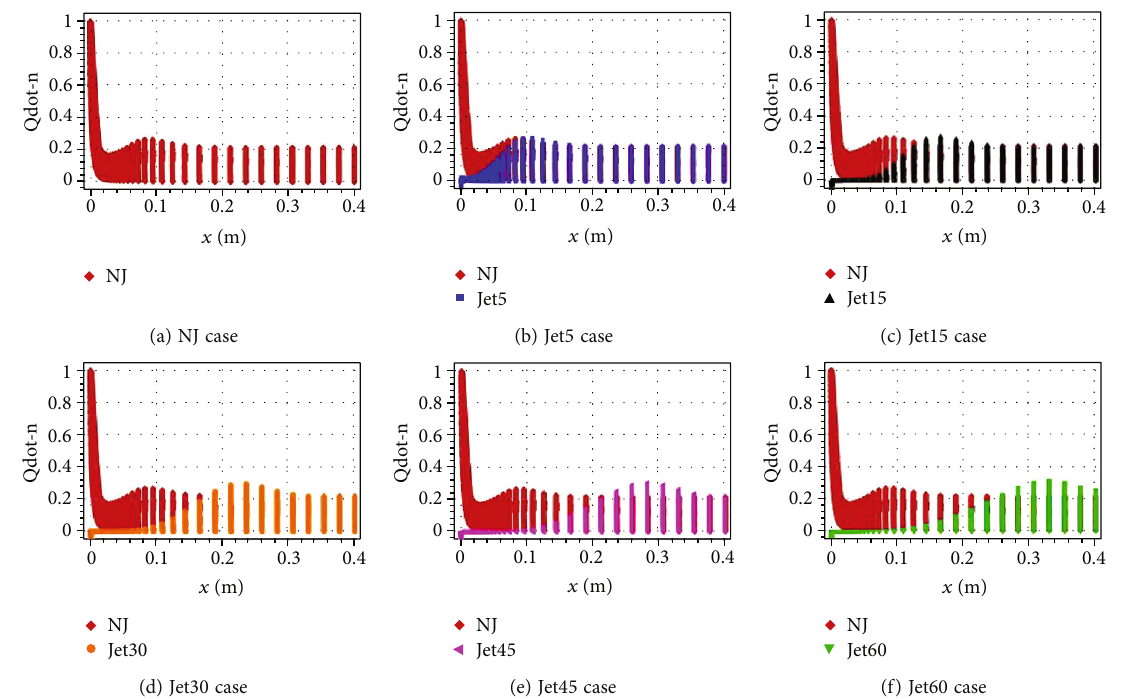
Figure 16: _ QN value of the NJ and J cases for di ff erent PRs of the H50Ma10 series.